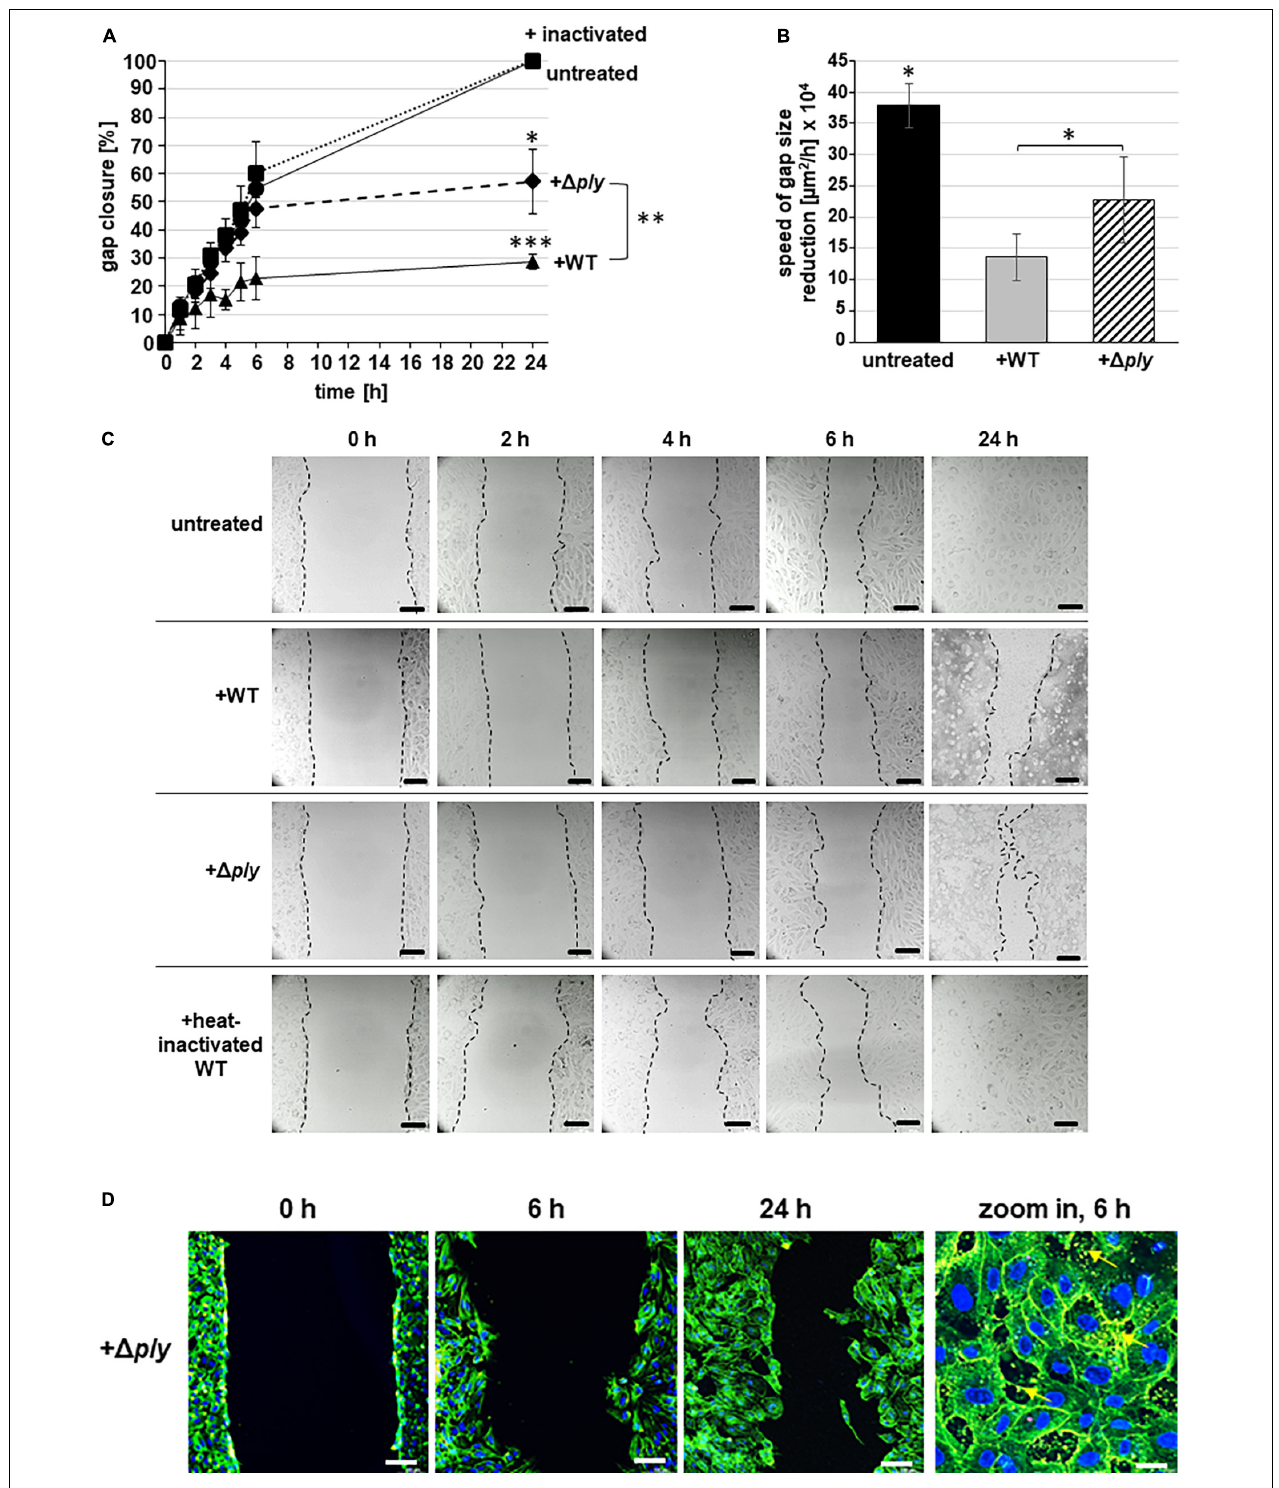
FIGURE 2 | CSMA with heat-inactivated and pneumolysin-deficient pneumococci. (A) Percentage of gap closure is calculated at indicated time points of CSMA for up to 24 h. Data derived from experiments with pneumococci at MOI of 10 (+WT, black line with triangles), with the pneumolysin-deficient strain (+ (cid:49) ply , dashed line with rombi), and with the same amount of heat-inactivated wild-type pneumococci (inactivated, dotted line with squares). Gap closure of untreated HUVEC was also determined as control (black line with filled circles). All experiments were performed in three independent assays, using three-chambered inlets, and the data